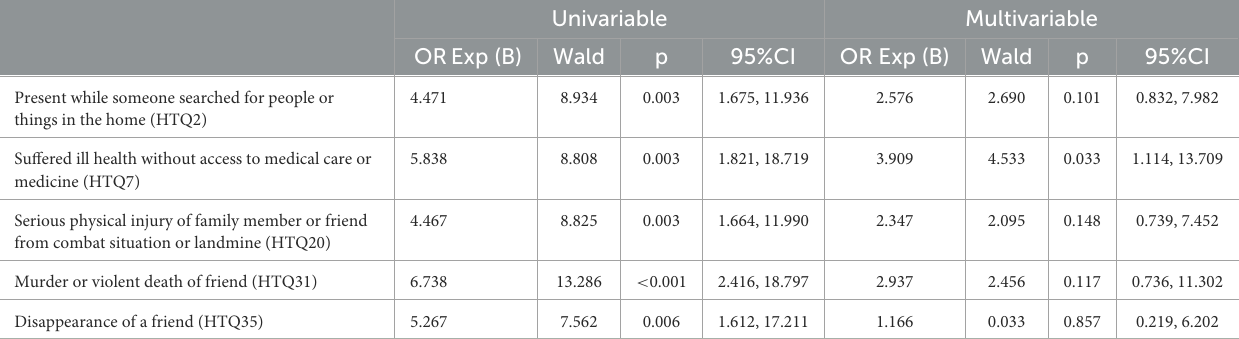
TABLE 3 Predictors of possible presence of clinically relevant posttraumatic stress